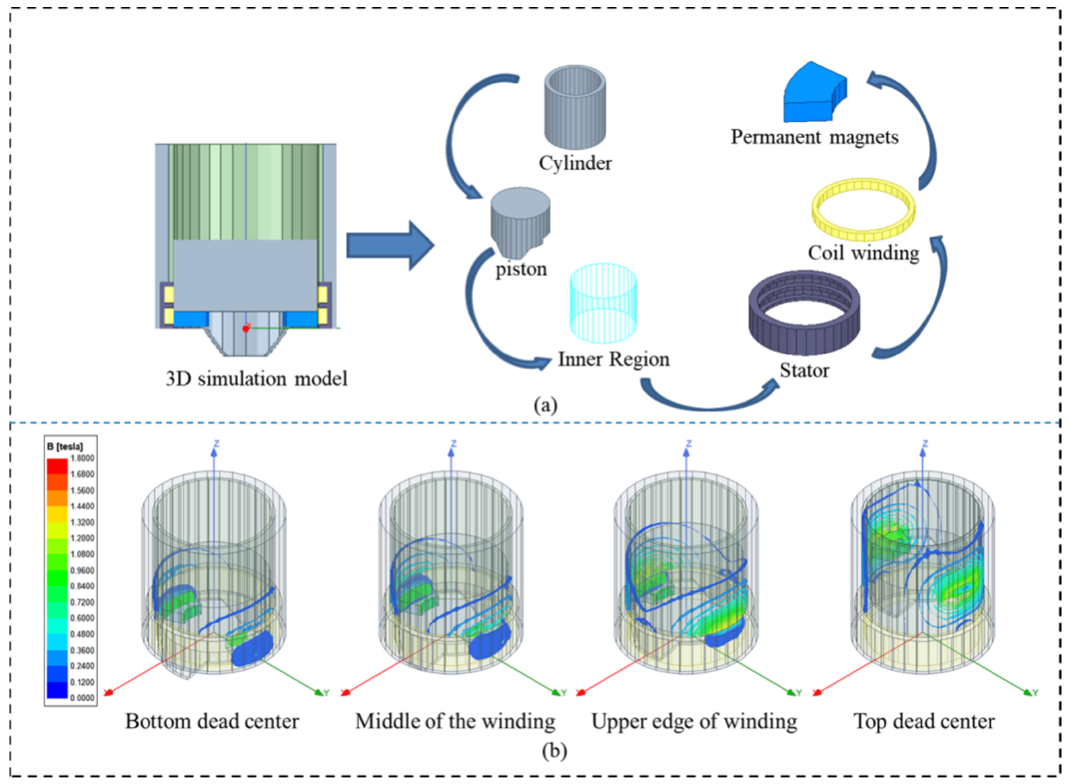
Figure 5. No-load simulation: ( a ) 3D simulation model; ( b ) cloud map of magnetic flux density dis- tribution.